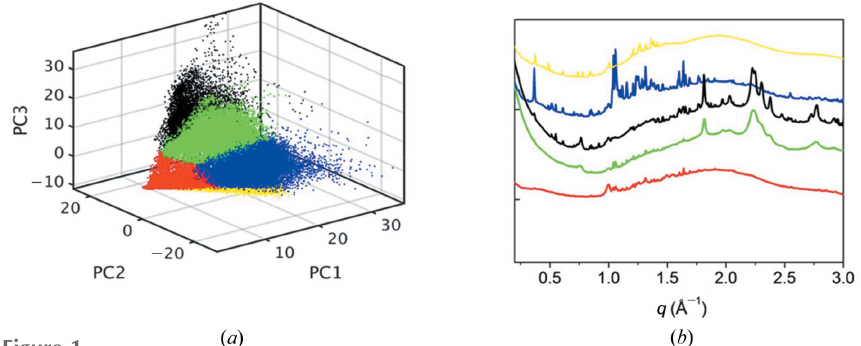
Figure 1 m WAXS signal classification. ( a ) Relative abundance of the principal components (PC1, PC2, PC3) for each profile of the entire m WAXS data set. Clusters of similar properties are highlighted in red, green, black, blue and yellow. ( b ) Representative signals extracted as an average of the furthest points from the centroids in each cluster of ( a